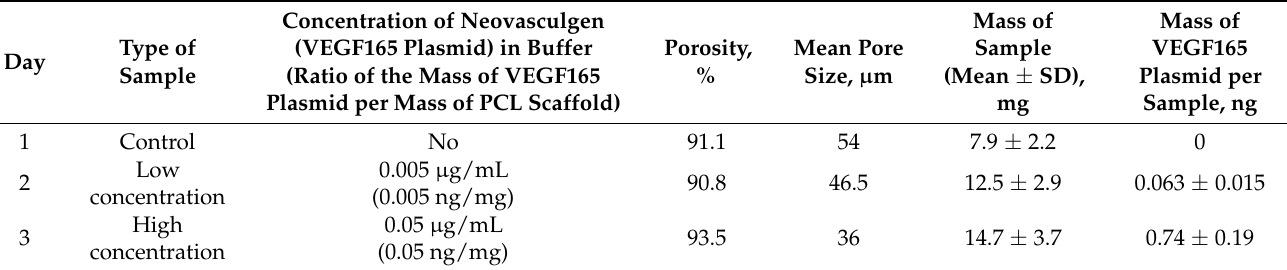
Table 1. Characteristics of fibrous scaffold samples.